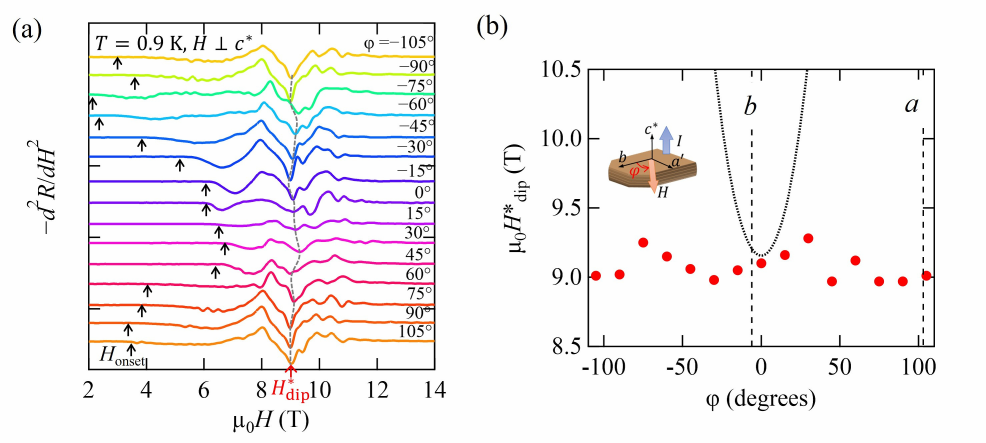
Figure 7. ( a ) Magnetic field dependence of the negative second-derivative curves at various in-plane field directions ϕ defined in the inset of ( b ). Each curve is shifted for clarity. The onset field H onset and the largest dip field H ∗ are indicated by black and red arrows, respectively. ( b ) H dip as a dip function of ϕ . The dotted curve indicates the expected value for the CM condition H dip ∝ 1/cos( ϕ ) with a single q vector.